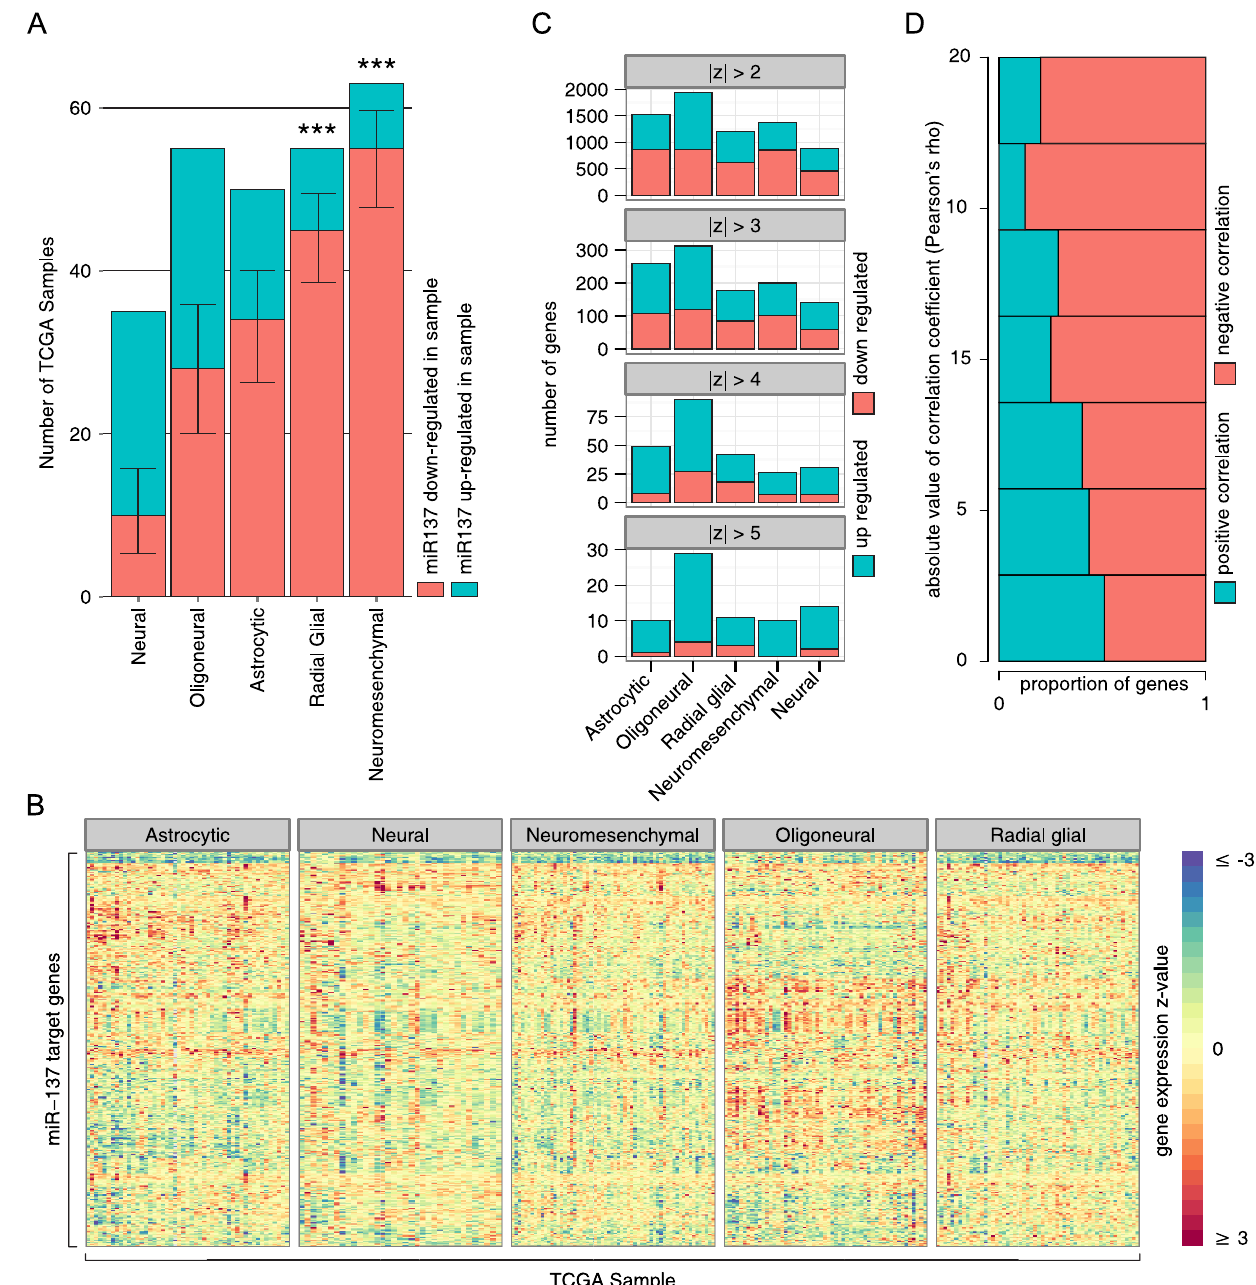
Figure 5. Expression analysis of miR-137 and its targets in the TCGA dataset. A ) Shown is the total number and proportion of TCGA samples analyzed with up- or down-regulation of miR137 (see methods for details). Error-bars are 95% confidence interval, and *** indicates p # 0.001, binomial test (two tailed, null hypothesis is a true proportion of 0.5). B ) The z-score of gene expression in 261 TCGA samples for the 595 miR137 target genes relative to normal tissue, stratified by GBM type as reported by Kim et al. [1]. C ) The number and proportion of up/down regulated genes amongst the 595 identified miR137 target genes in 261 TCGA GBM samples. Four different thresholds for significant change are shown (absolute value of z-score relative to normal tissue greater than 2, 3, 4 or 5). Samples are stratified by GBM type (x-axis), as defined in Kim et al. [1]; if a gene is up or down regulated in multiple samples, it is counted once for each sample showing a significant change. D ) Proportion of genes with positive or negative correlation with miR137 (x-axis) for increasing correlation coefficient threshold cut-offs (y-axis); higher correlations tend to be predominantly negative. doi:10.1371/journal.pone.0085591.g005 mRNA [24]. Therefore, a decrease in association of PABP with Many published studies attempt to justify the involvement of tumor suppressor miRNAs or oncomiRs in tumorigenesis based on mRNAs upon miR-137 action could be a direct measurement of its activity. their action on a small set of genes or sometimes a single target. In most cases if not all, the conclusions are an oversimplification of a